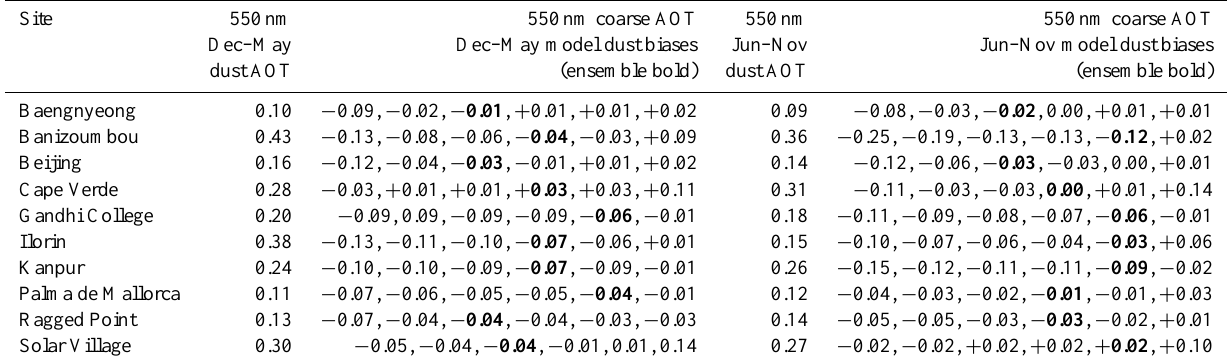
Table 2. Same as Table 1 but for coarse mode AOT, and for those sites in which the coarse mode is dominated by dust. This includes the ICAP core and NGAC models.